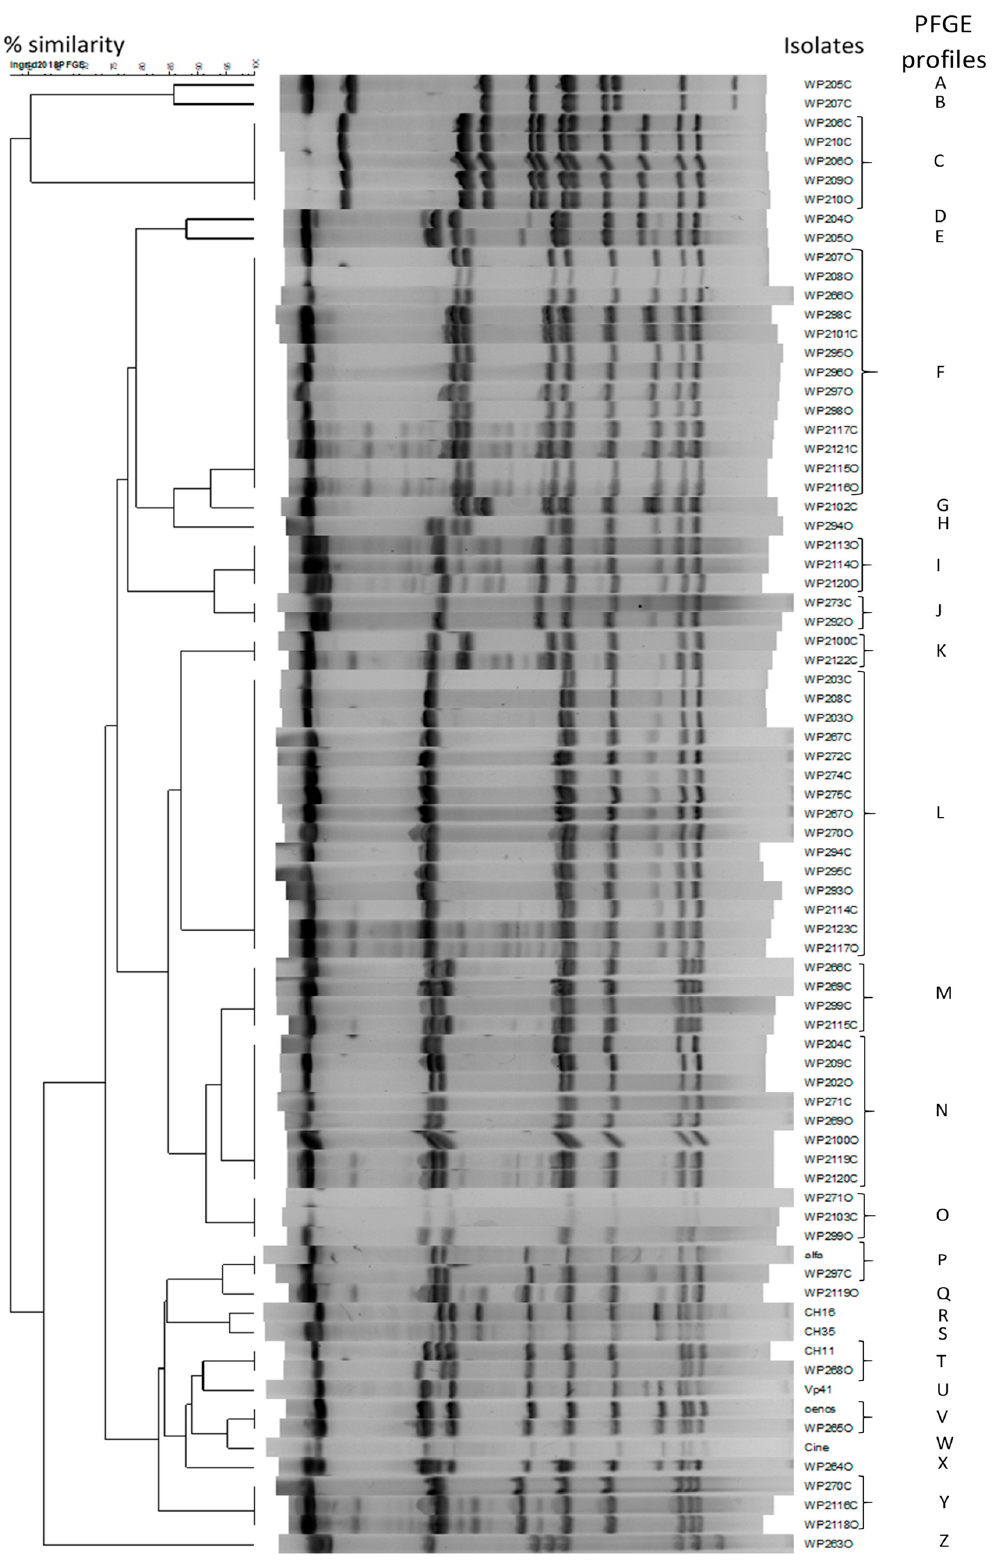
Figure 2. Dendrogram based on the Not I Pulsed-field gel electrophoresis of rare restriction enzyme digests (REA-PFGE) profiles of the 19 unrelated patterns of the 80 O. oeni strains isolated in this study, and seven commercial O. oeni strains.